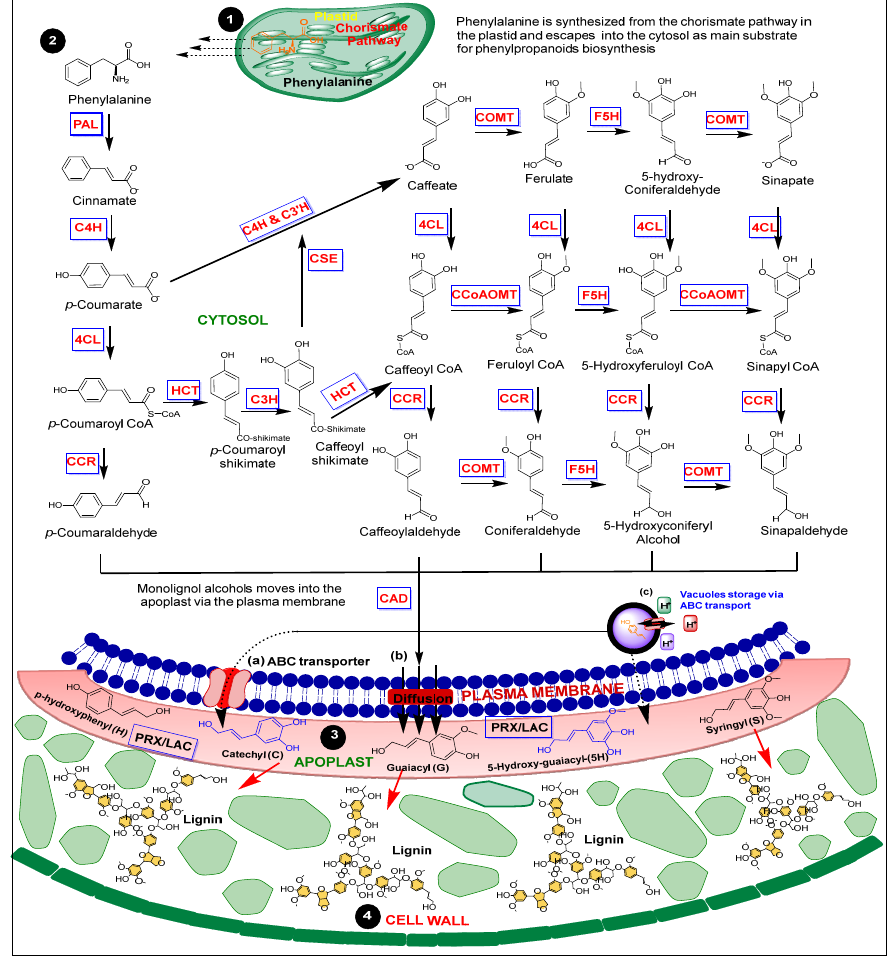
Figure 1. Monolignols biosynthesis and polymerization. The various enzymes leading to monolignol formation are based on current understanding: traditional monolignols (black) and recently discovered monolignols in some plant species (blue). Stage 1: Phenylalanine escapes from the chorismate pathway in the plastid into the cytosol. Stage 2: Enzymatic activities that occur prior to monolignol formation. Stage 3: Monolignols are transported into the apoplast. Stage 4: PRX/LAC encodes monolignol polymerization into lignin. Lignin fills up intercellular voids to enhance cell wall rigidity. Proposed mechanism of monolignol transport: ( a ) ABC transporters mediate active trafficking of monolignols. ( b ) Trans-membrane diffusion of monolignols/channels-facilitated membrane transport. ( c ) ABC transporters channel monolignol glycoside into vacuoles for release at cell death.